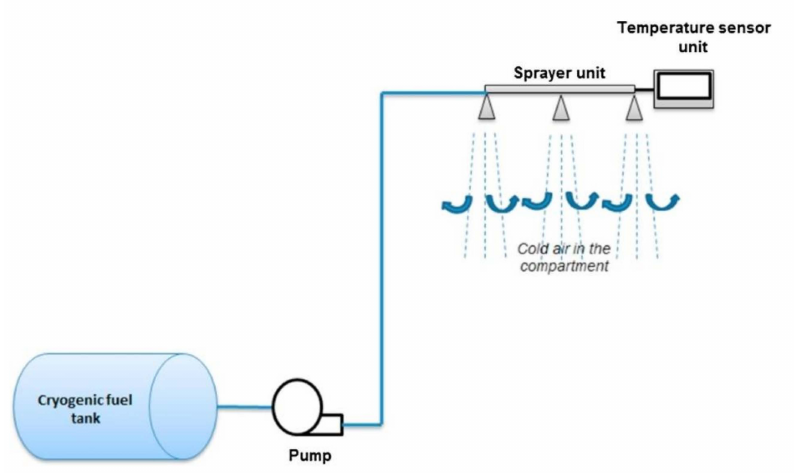
Figure 9. Schematic diagram of direct cryogenic transport refrigeration system. Reprinted from ref.